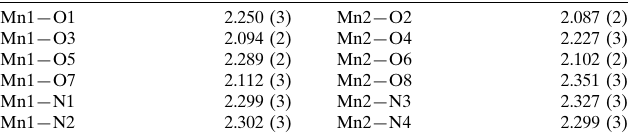
Selected bond lengths (A˚ ).